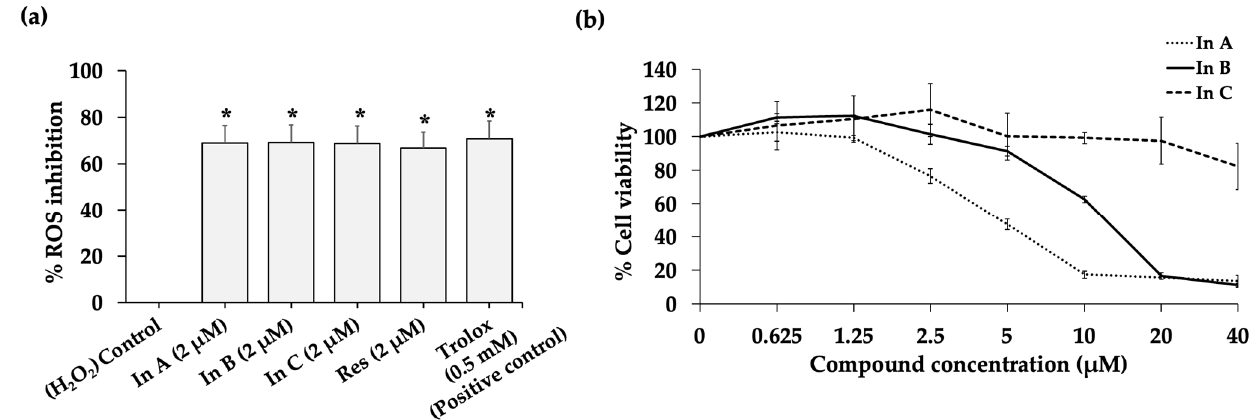
Figure 2. ( a ) Reactive oxygen species (ROS) scavenging activity was measured by the DCFH-DA assay after 2 µ M In A (interruptin A), 2 µ M In B (interruptin B), 2 µ M In C (interruptin C), and 2 µ M Res (resveratrol) compound treatments. A small amount (0.5 mM) of Trolox was used as a positive control. Data represent the mean ± SD values from three independent experiments. The significance of the mean differences was analyzed using Kruskal–Wallis with Dunn’s test. * p < 0.05 compared to the control. ( b ) Cell viability in the MTT assay at 72 h after treatment with In A, In B, and In C in HaCaT human keratinocytes. Data represent the mean ± SD values from three independent experiments.